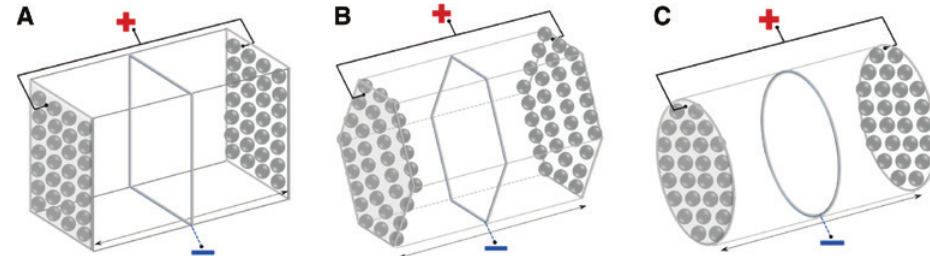
Figure 1: Schematics of the proposed electro-tunable Fabry–Perot interferometers comprising dual mirror-on-mirror nanoplasmonic metamaterials as the cavity mirrors, where the cavity is filled with an aqueous solution of nanoparticles. Nanoparticles capped with negatively charged ligands assemble on positively polarized thin metallic film electrodes of (A) rectangular/ square, (B) polygon, or (C) circular shape, forming electrically tunable mirror-on-mirror metamaterials. The frames shown in the middle of the insulating cavity side walls act as the negatively polarized